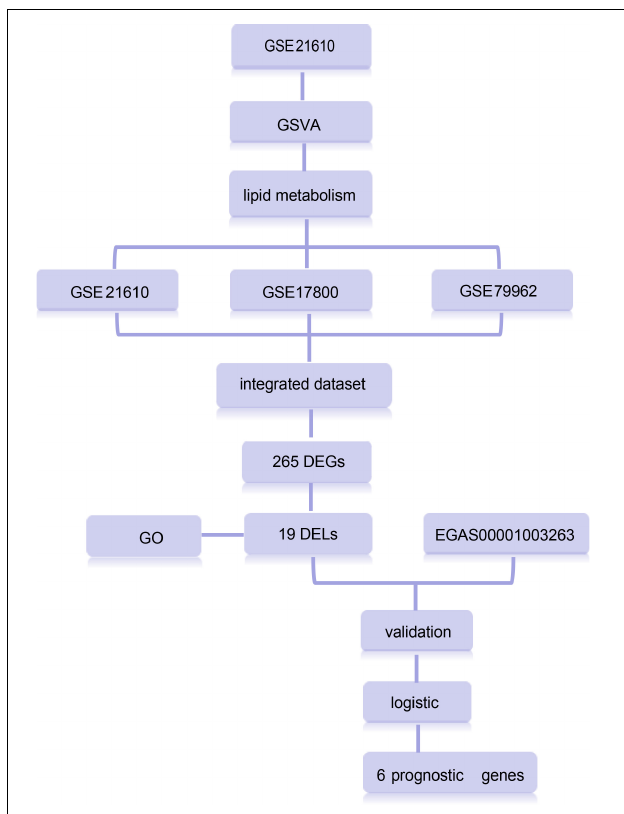
FIGURE 1 | Overview of study